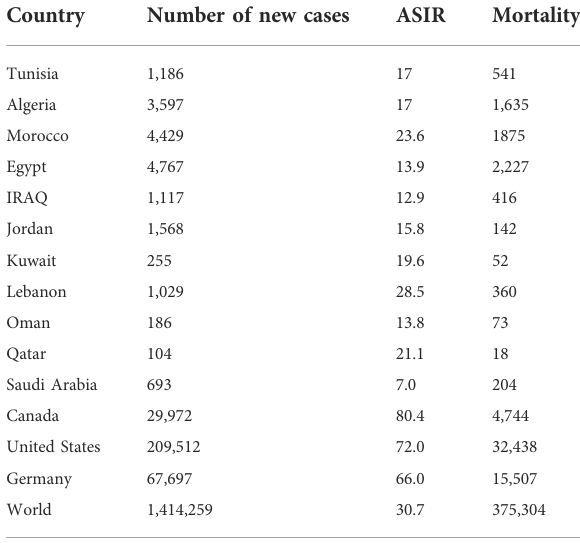
TABLE 2 Mortality rate among Middle East countries and Canada, America, and Europe. Country Number of new cases